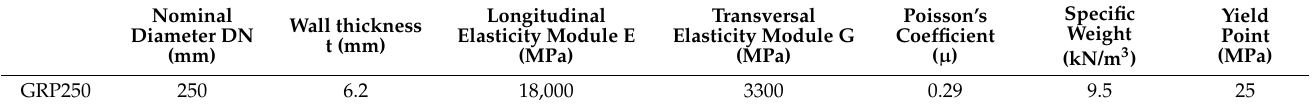
Table 1. Mechanical and Elastic Features of GRP